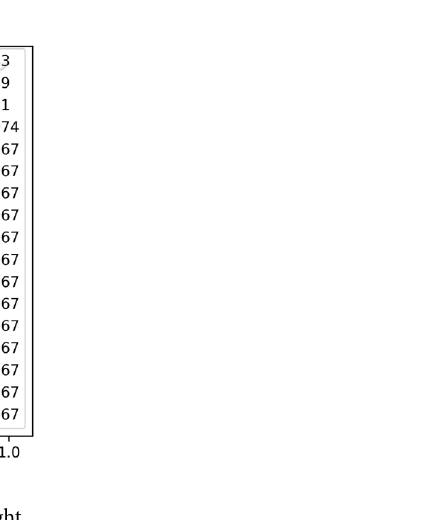
Figure 9. ROC of the DT with RFE. AUC is shown on the